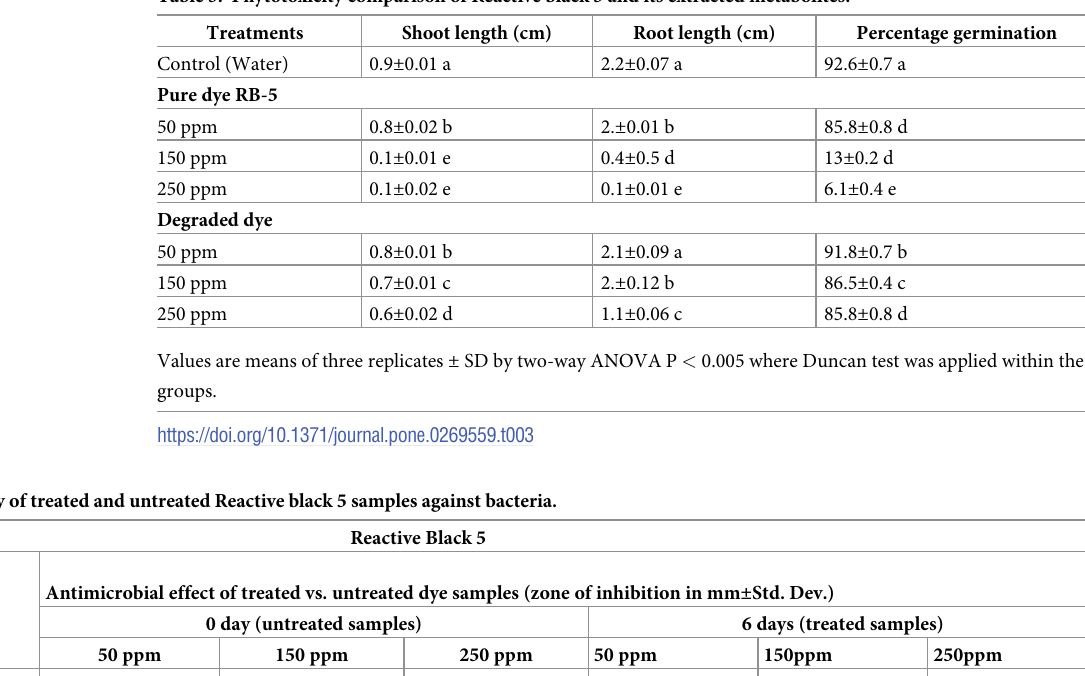
Table 3. Phytotoxicity comparison of Reactive black 5 and its extracted metabolites.